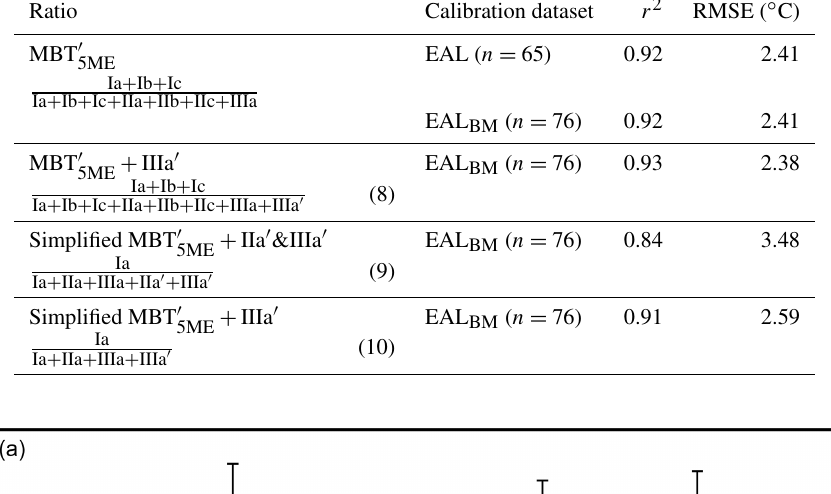
Table 1. Temperature calibrations – ratios, calibration dataset, r 2 , and root-mean-square error (RMSE) in degrees Celsius ( ◦ C) – East African